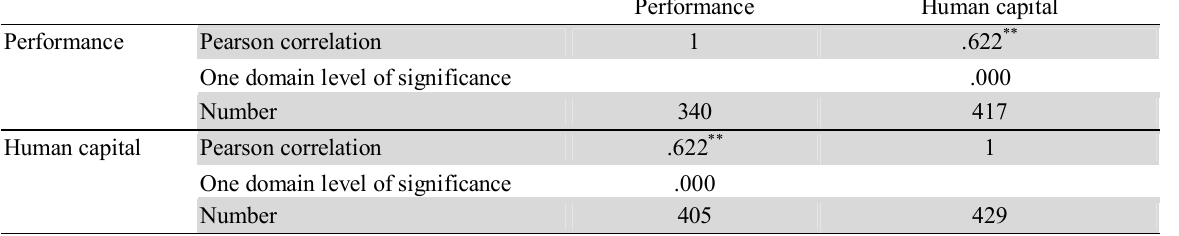
The summary of Pearson correlation between employee performance and human capital Performance Human capital Performance Pearson correlation 1 .622 ** One domain level of significance .000 Number 340 417 Human capital Pearson correlation .622 ** 1 One domain level of significance .000 Number 405 429